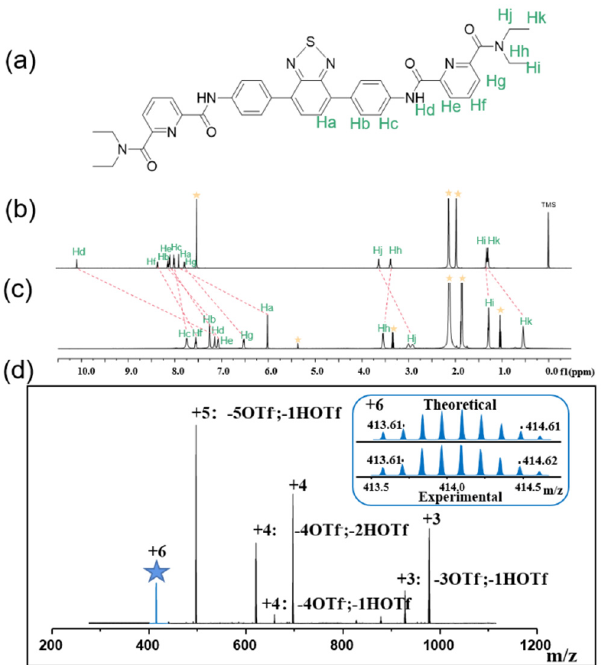
Figure 2. ( a ) The structure of L-B . ( b ) 1 H NMR spectra (600 MHz, CD 3 CN/CDCl 3 = 1:1), 298 K) of L-B (the solubility of L-B in CD 3 CN was poor, and CDCl 3 was added to help dissolve). ( c ) 1 H NMR spectra (600 MHz, CD 3 CN, 298 K) of C A [the yellow five-pointed star label indicates the solvent peak]. ( d ) ESI-MS spectra of C A and showing the observed z = +6 charge for the peak at m/z = 414.11 (bottom) compared to the theoretical isotopic pattern (top).